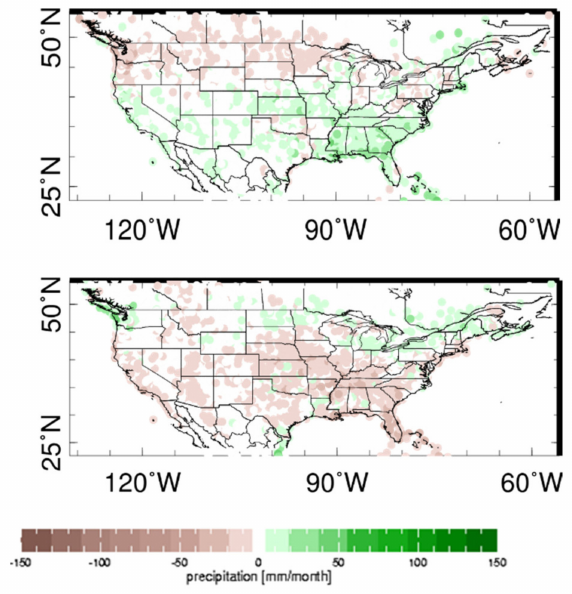
Figure 15. Precipitation anomalies in El Niño ( top ) and La Niña ( bottom ) years in the March–May following the ENSO peak